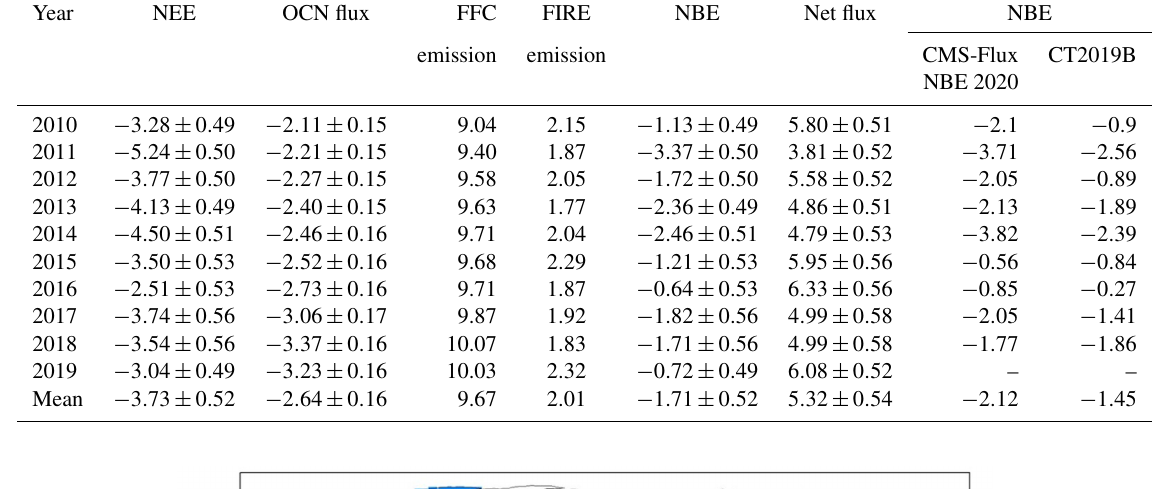
Table 1. Global carbon budget (PgCyr − 1 ).